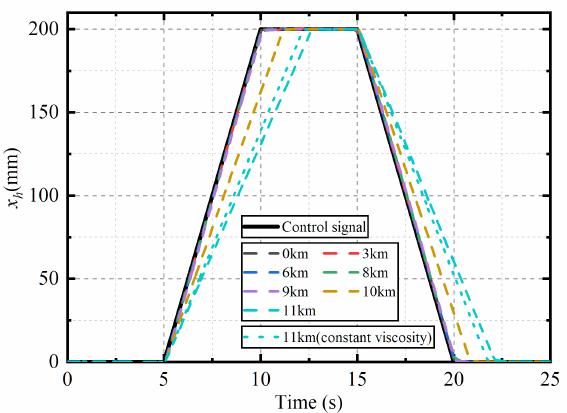
Figure 9. Displacement output, x h , at different depths.